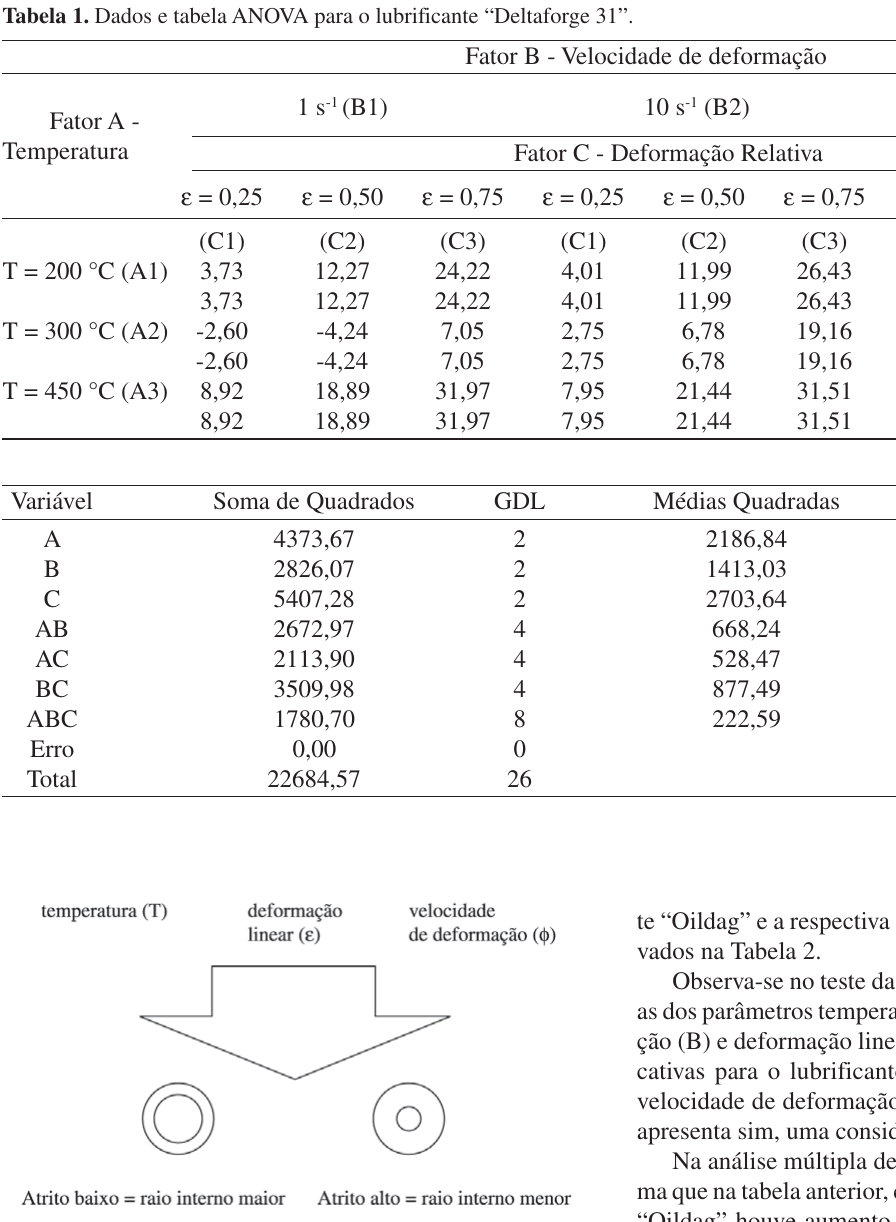
Figura 8. Esquema de análise do ensaio do anel.